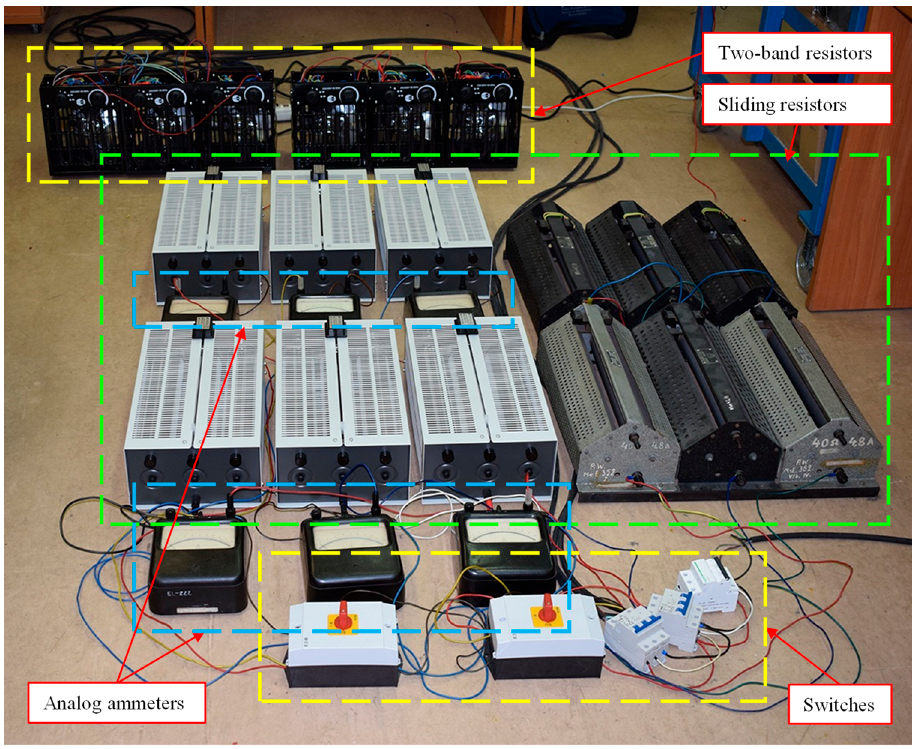
Figure 5. Laboratory test stand: energy dissipation system.